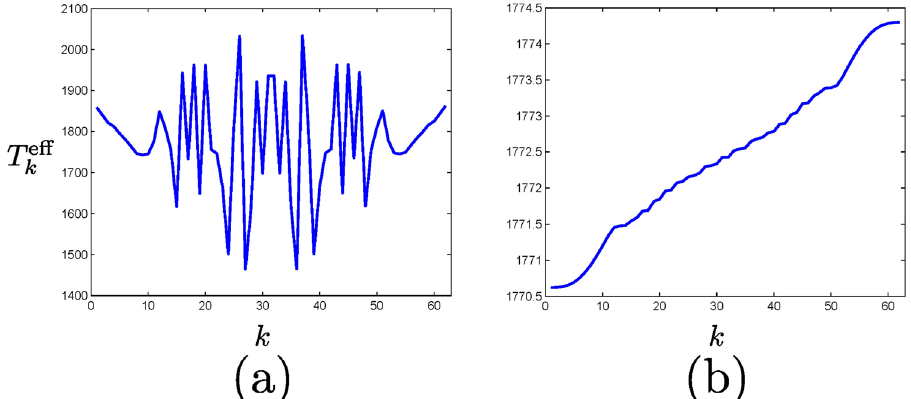
eff on the specific mode k for: ( a ) an arbitrary distribution of defects, and ( b ) when Figure 4. Dependence of T k either ΘΣ y or R π symmetry is satisfied. T h = 2500 K and T c = 1500